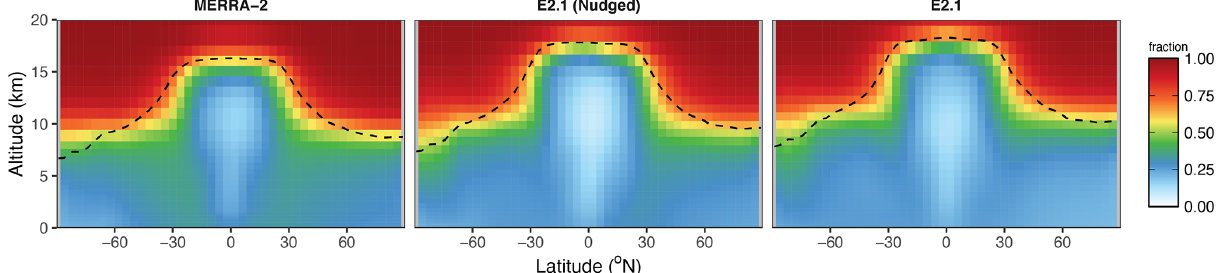
Figure 13. Zonal mean fraction of 7 Be that was produced in the stratosphere in GEOS-Chem driven by MERRA-2, E2.1 nudged to MERRA- 2 and E2.1. Zonal mean tropopause height in each simulation is shown as a dashed line.